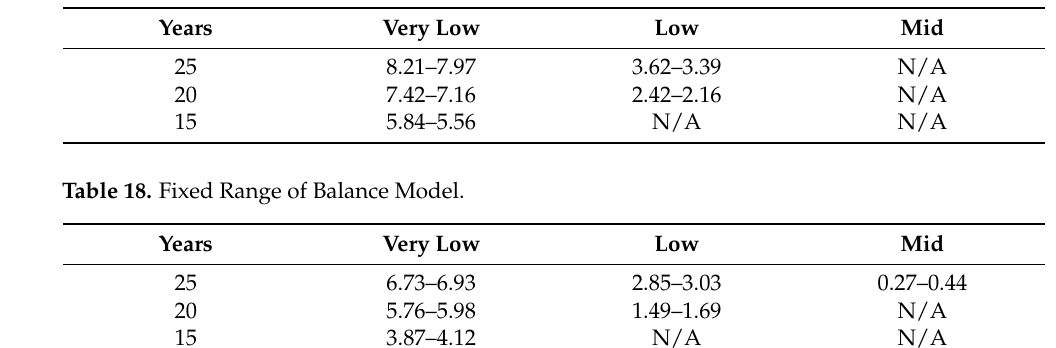
Table 16. Floating Discount Rate Pure Case.